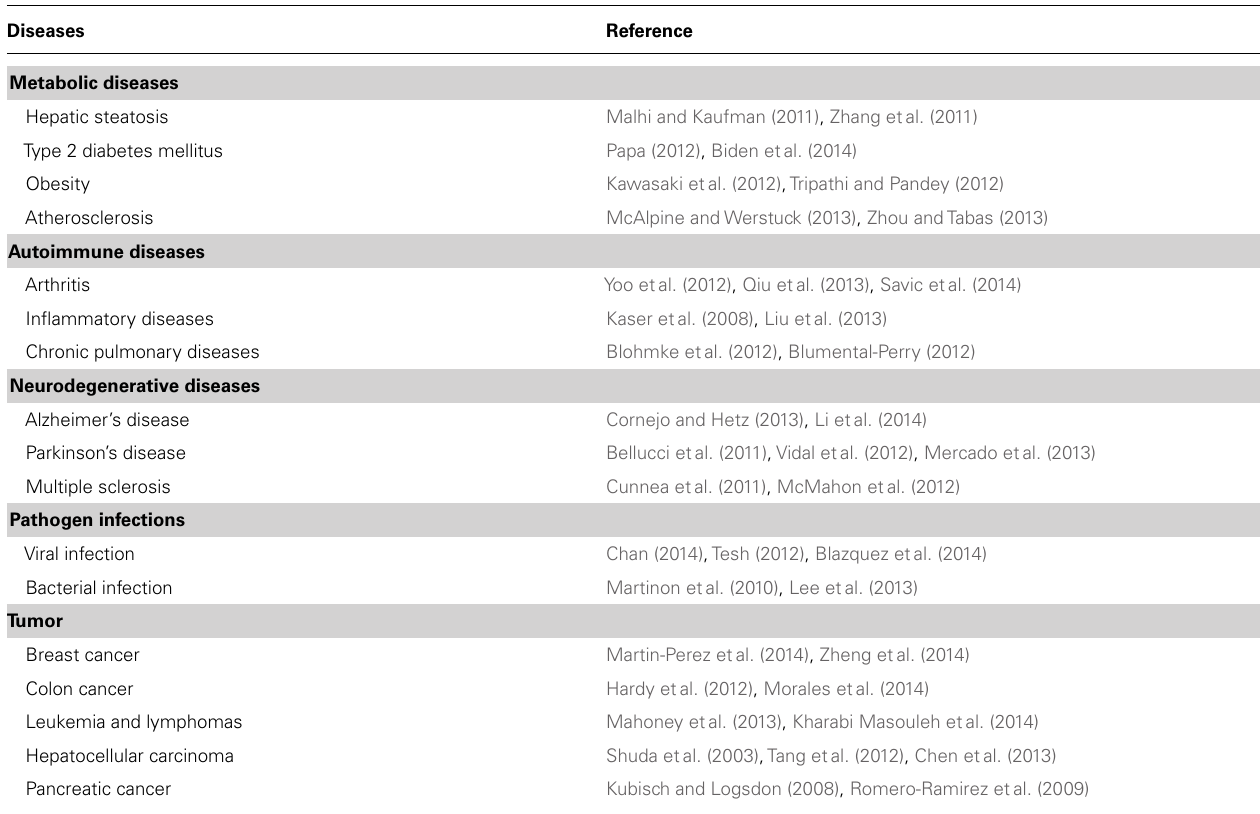
Table 1 |A list of diseases linked to dysregulated ER